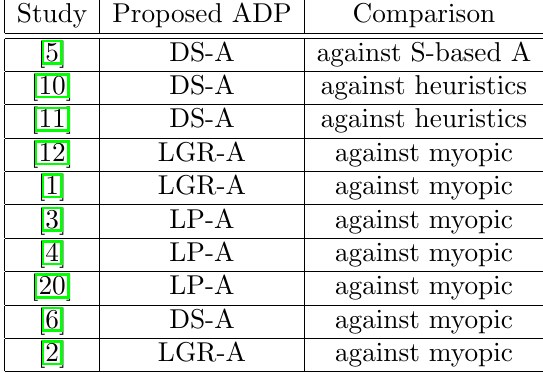
Table 1. The list of work in